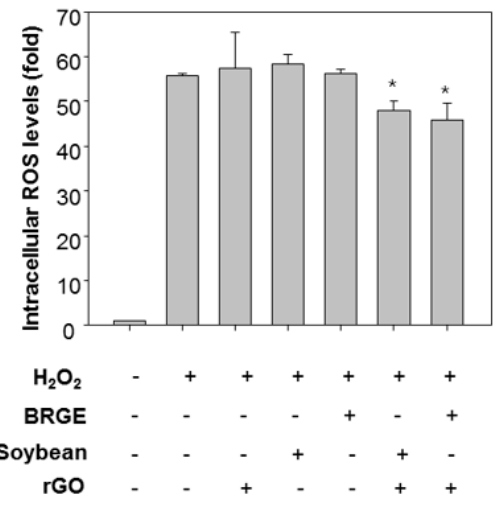
Figure 5. Effect of reduced graphene oxide with black rice with giant embryo/soybean extract on intracellular ROS levels. B3 cells were stained with DCF-DA (25 µ M) for 30 min, and treated with each colored grain (10 µ g/mL) in the presence or absence of rGO (10 µ g/mL), and 100 µ M of H 2 O 2 3 h. The fluorescence was measured at a wavelength of 483(ex)/535(em). * p < 0.05 vs. H 2 O 2 -treated cells.